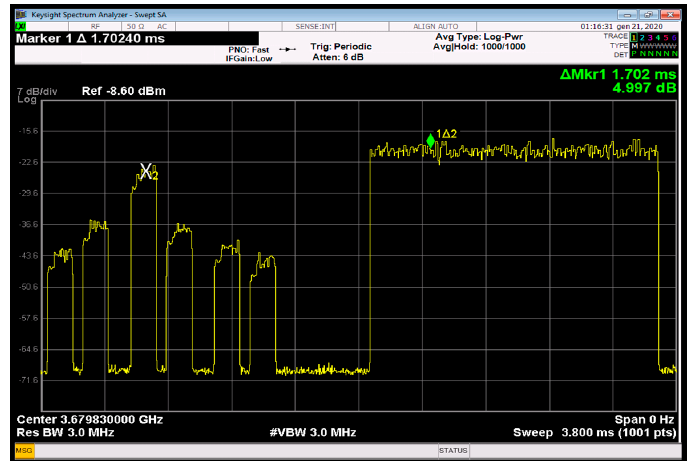
Figure 4. Representation of the effect of beamforming. While the SSBs are associated to a finite number of pre-selected beams, data traffic are transmitted using a beam focused toward the user equipment .